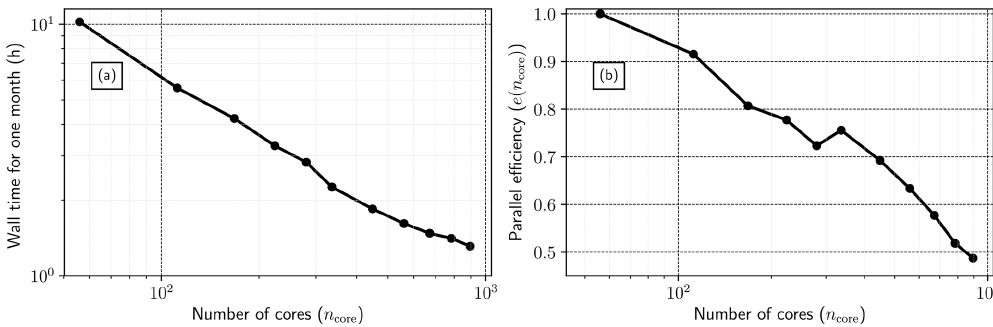
Figure B1. (a) Wall time required for simulating 1 month and (b) parallel efficiency of PARASO (see Eq. B1). Note that in panel (a) , both axes are log scaled; in panel (b) , the x axis